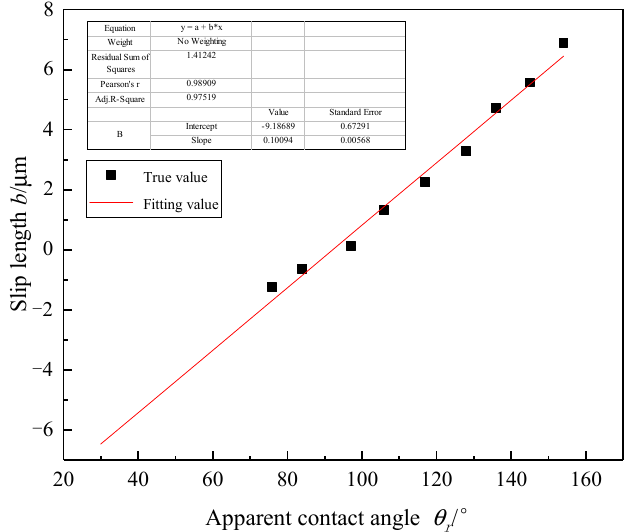
Figure 7. The influence of apparent contact angle on slip length.